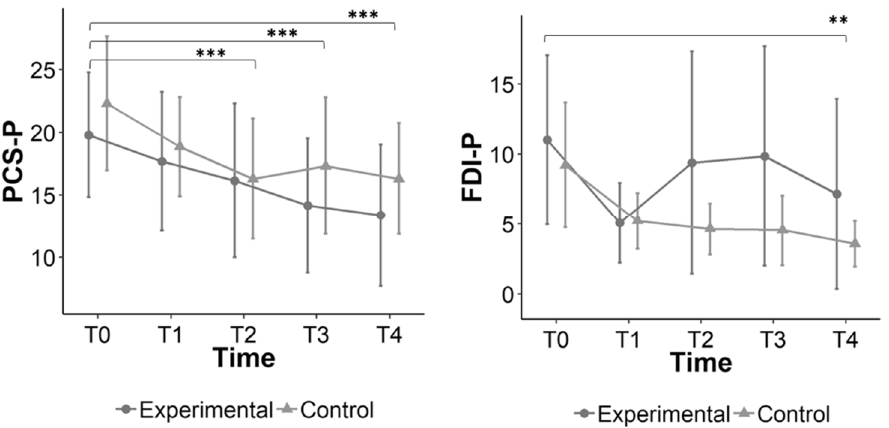
Figure 2. Graphs showing the mean difference over time for the primary outcomes with